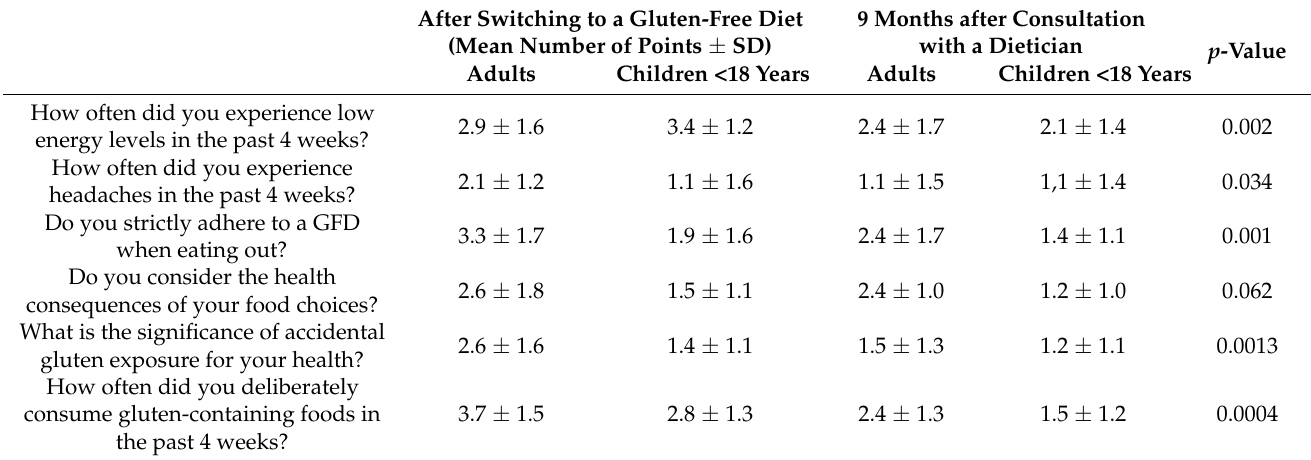
Table 4. Celiac Disease Adherence